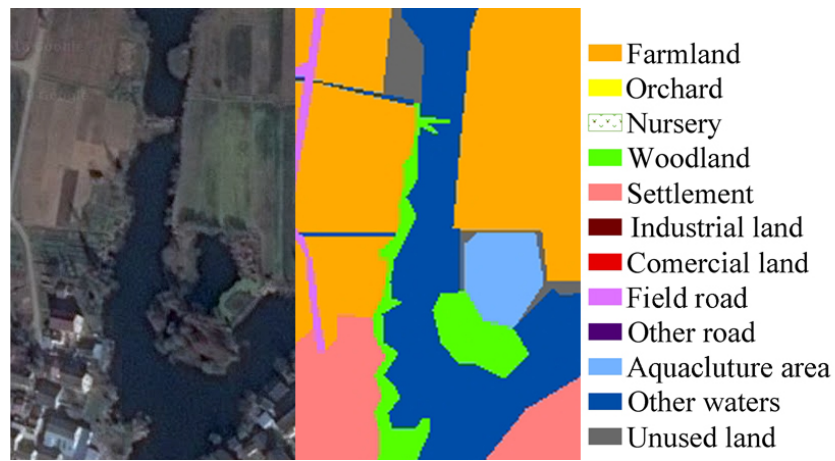
Figure 2. An example of a result from the local field surveys. The left picture is a remote sensing image displaying a base map in a field survey. The right picture is a digitalized map showing local land use. The small woodland patches along the river and around settlements could be accurately identified, and areas of aquaculture could be distinguished from other waters through local field surveys. Table 1. Land use composition and landscape metrics in 2012.